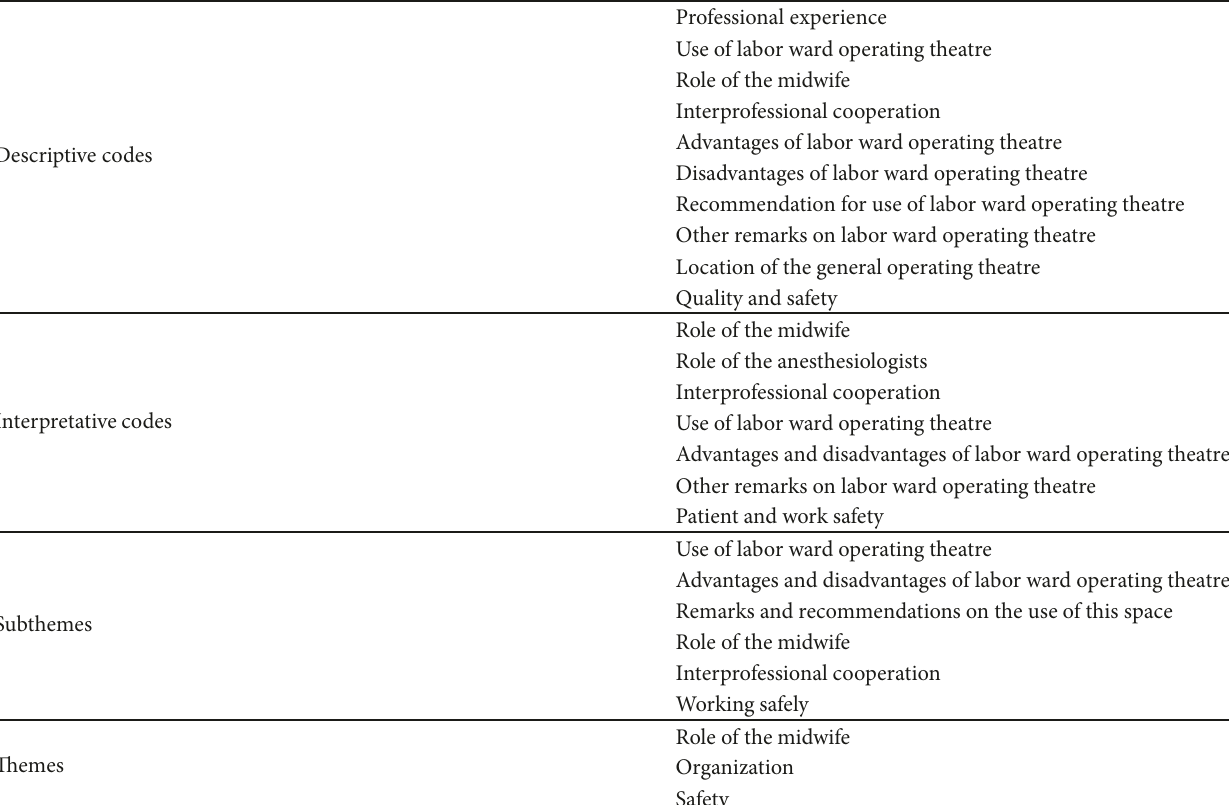
Table 1: Codetree.